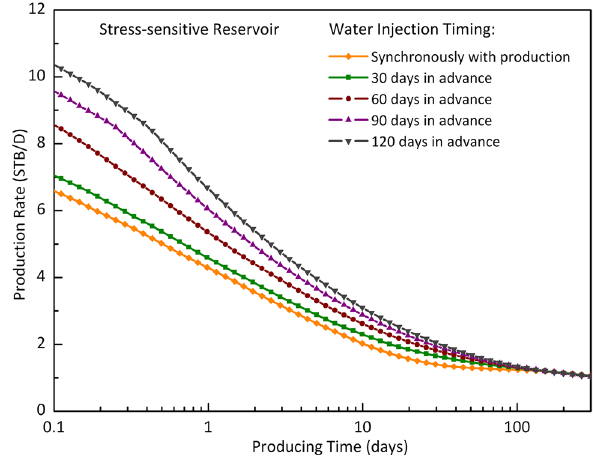
Fig. 11 Relative permeability curves by core experiments